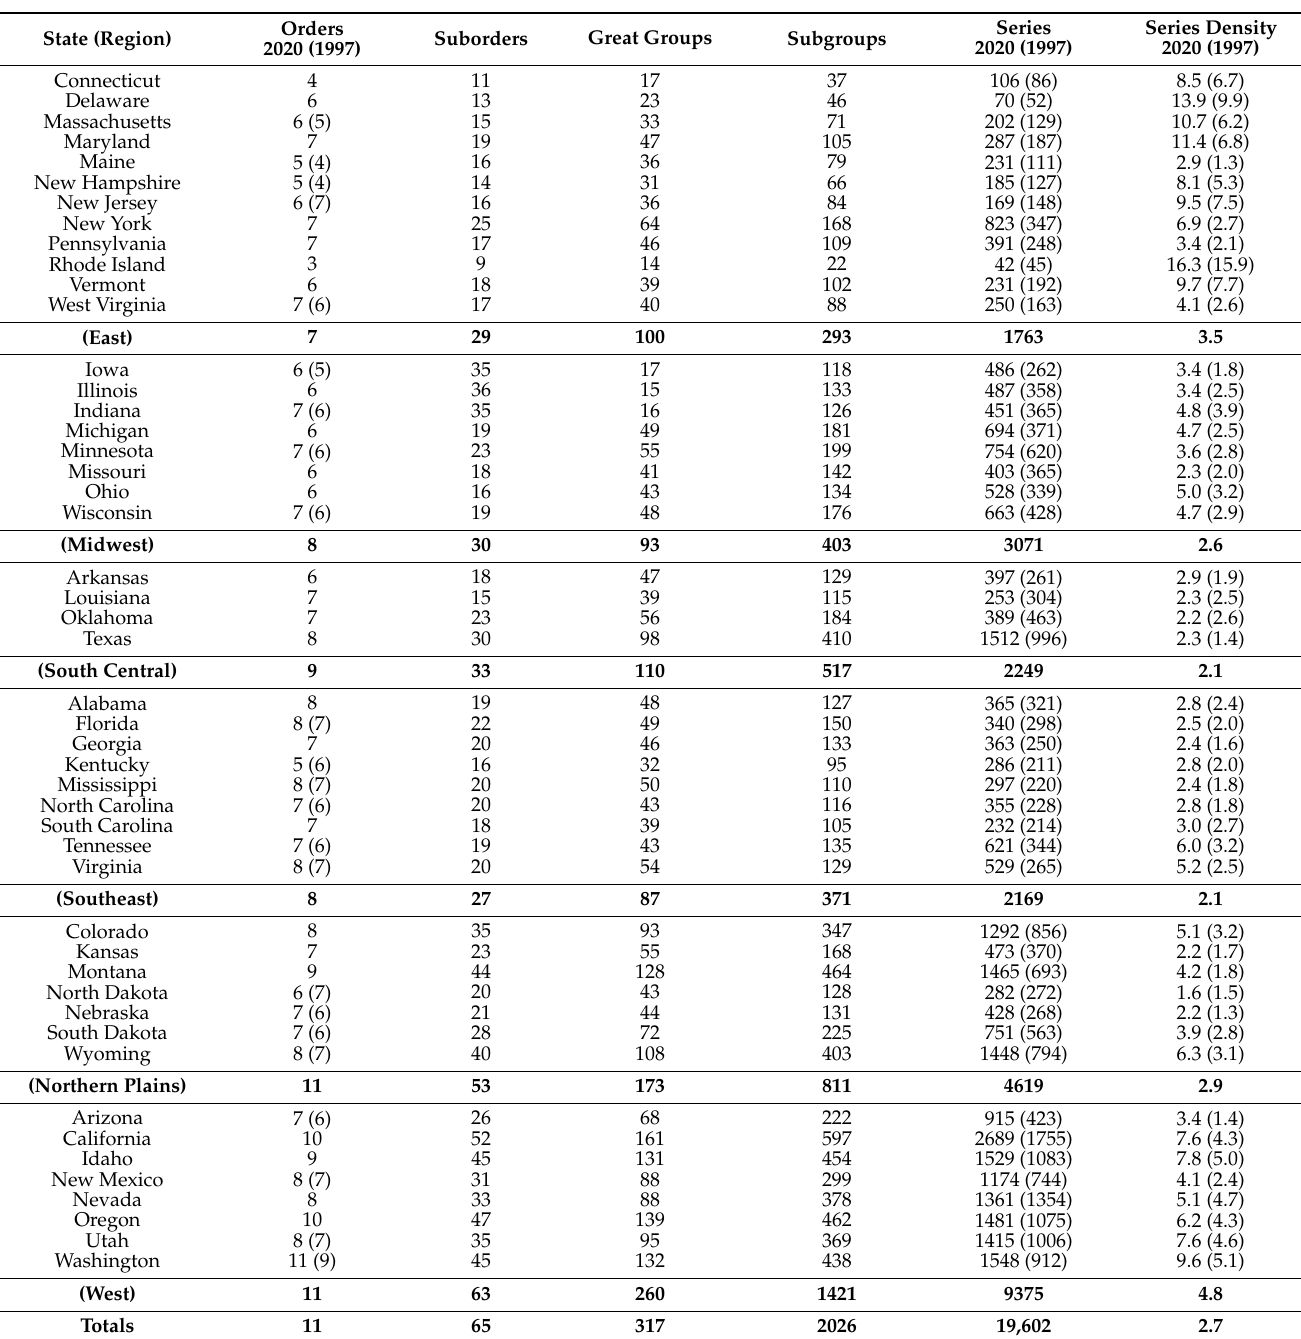
Table 10. Soil diversity (pedodiversity) expressed as the number of soil classes (taxonomic pedodiversity) within states (regions) in the contiguous United States (U.S.) based on Soil Survey Geographic (SSURGO) Database (2020) [27] with comparisons based on STATSGO (1997)